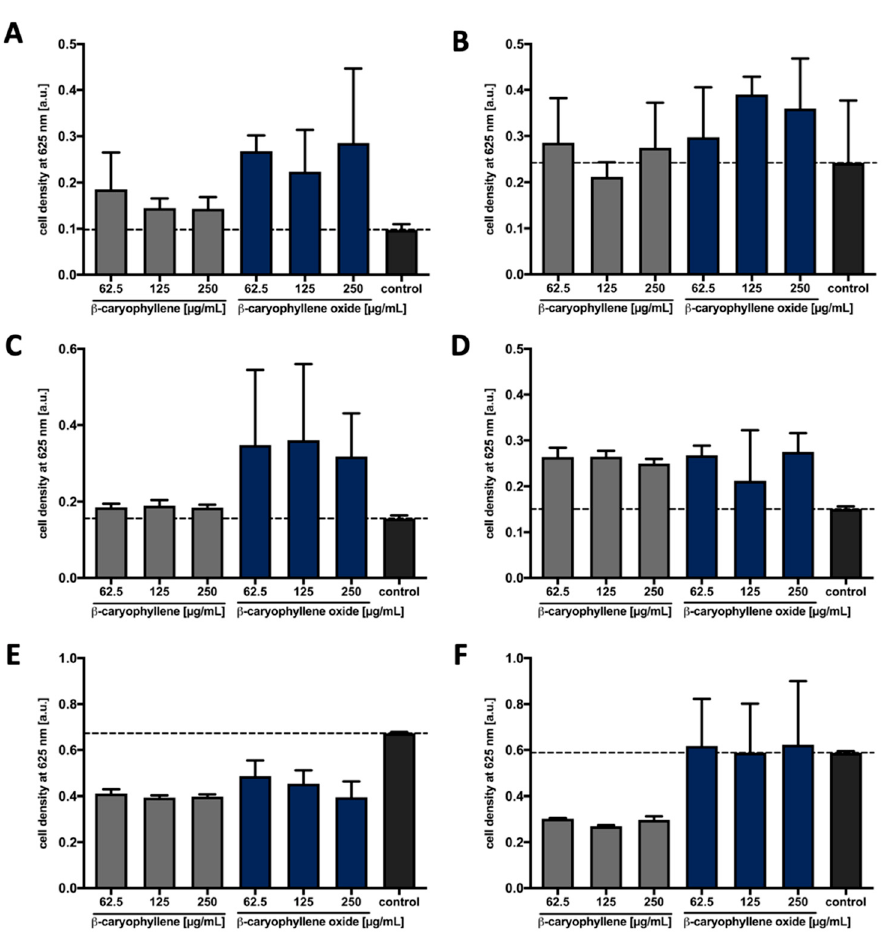
Figure 4. The influence of β -caryophyllene and β -caryophyllene oxide on the growth of plant growth-promoting bacteria. Final concentrations of 62.5 µg mL − 1 , 125 µg mL − 1 and 250 µg mL − 1 of β -caryophyllene (grey bars) and β -caryophyllene oxide (blue bars) were added to cultures of R. rhizogenes ( A ), R. capsulatus ( B ), B. subtilis ( C ), P. polymyxa ( D ), P. fluorescens ( E ) and P. putida ( F ) in 100 µL MH medium ( R. capsulatus in RCV medium) in MTPs. The final solvent concentration was 1% ( v/v ) Tween 20 and 0.5% ( v/v ) DMSO. To determine the influence of the terpenes on the growth of the bacteria, the cells were incubated stationary for 20 h at 37 °C ( R. capsulatus at 30 °C) and the cell density was measured at 625 nm using a plate photometer. The solvent control (control, black bars) was MH or RCV medium containing 1% ( v/v ) Tween 20 and 0.5% ( v/v ) DMSO. Values are means of three inde- pendent biological replicates ( n = 3) and error bars indicate the respective standard deviations.